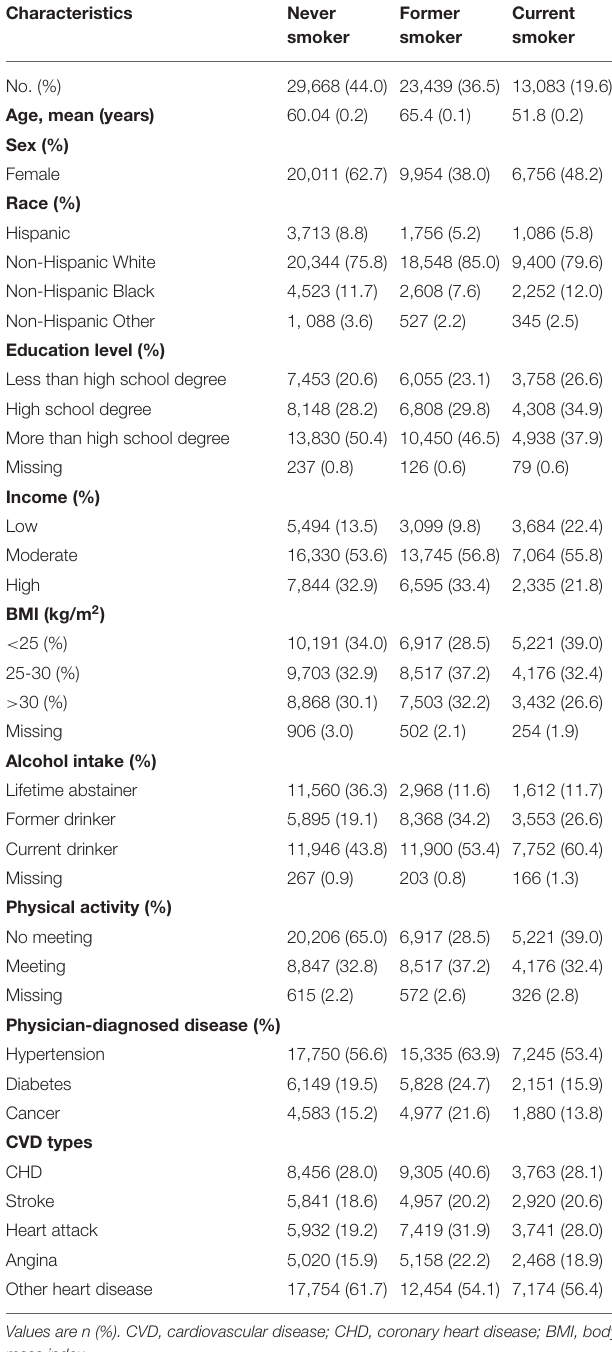
TABLE 1 | Baseline demographic characteristics of CVD patients, according to smoking status.